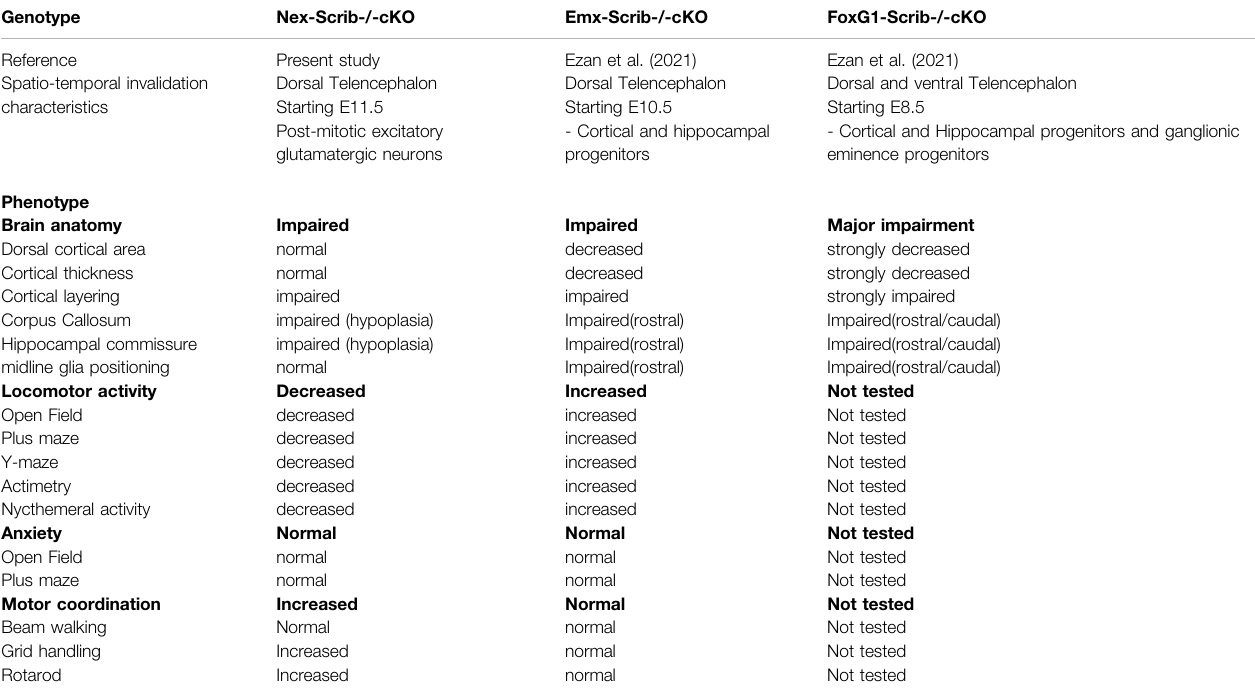
TABLE 1 | Comparison of anatomical and behavioral phenotypes in different Scrib conditional Ko mice